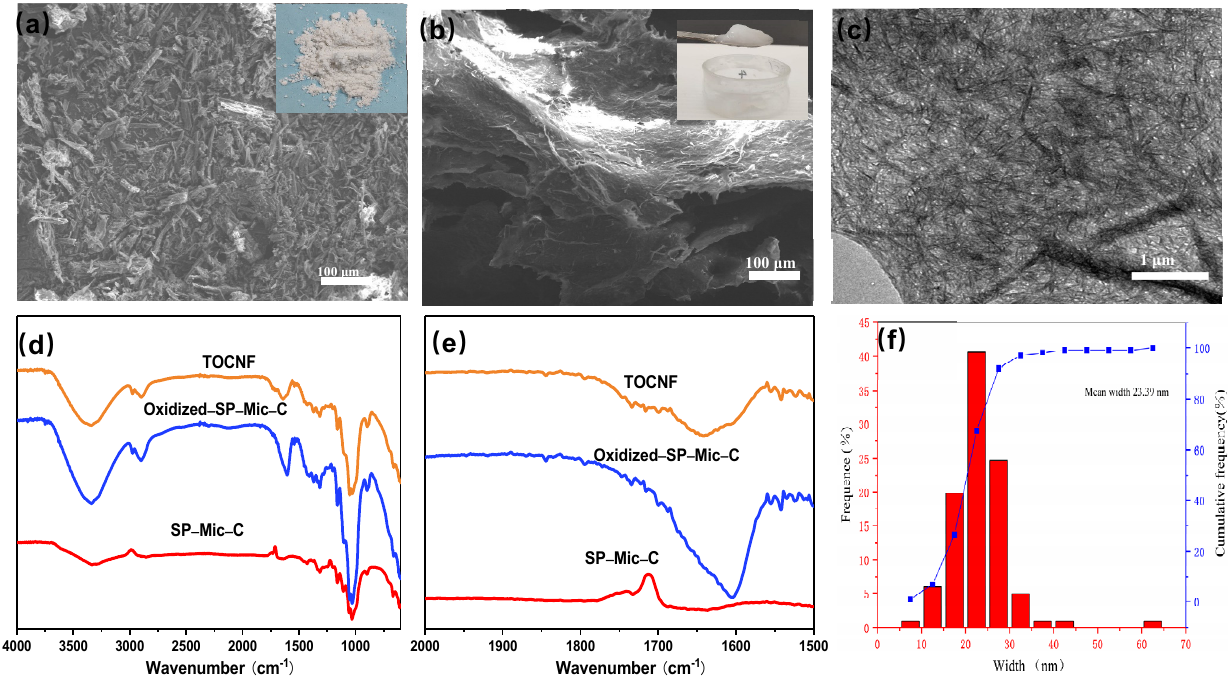
Figure 1. Scanning electron microscope (SEM) images of: ( a ) Salix psammophila microcrystalline cellulose (SP-Mic-C); ( b ) Salix psammophila nanofibers (TOCNF); ( c ) transmission electron microscope (TEM) images of TOCNF; ( d , e ) Fourier-transform infrared spectroscopy (FTIR) of SP-Mic-C, oxidized Salix psammophila microcrystalline cellulose (oxidized-SP-Mic-C), and TOCNF; ( f ) TOCNF diameter distribution.